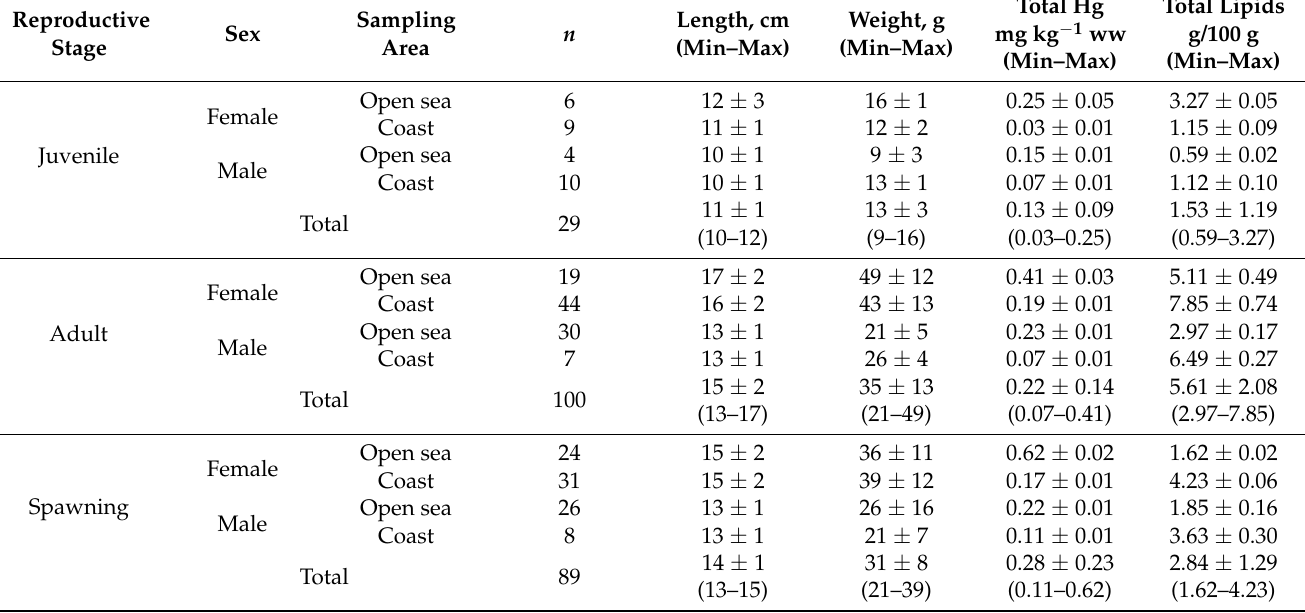
Table 1. Concentrations of total mercury (THg) and total lipids in muscle tissues of M. barbatus samples from the Adriatic Sea. Reproductive stage, sex, sampling area, and biometric data of investigated fish. n , number of fish samples; mean value ± standard deviation; range (min–max) of length, weight, THg, and total